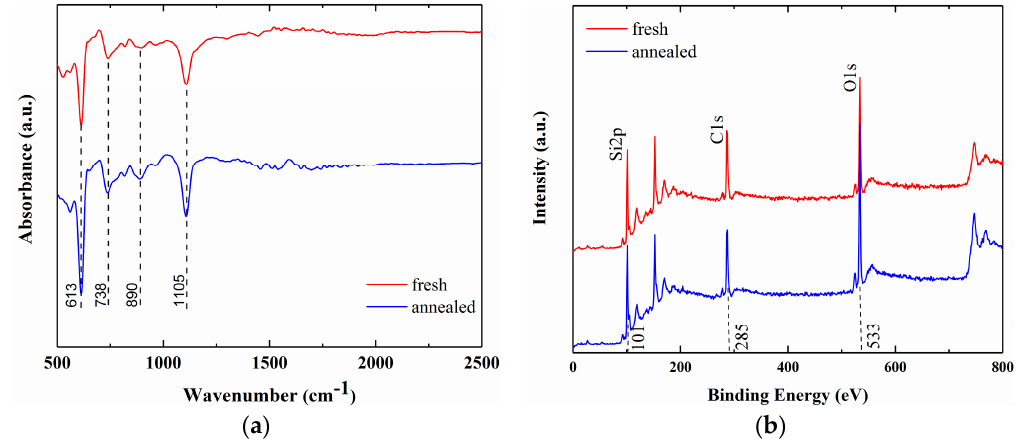
Figure 7. Spectra of ( a ) FTIR and ( b ) XPS obtained from freshly prepared and annealed sample.